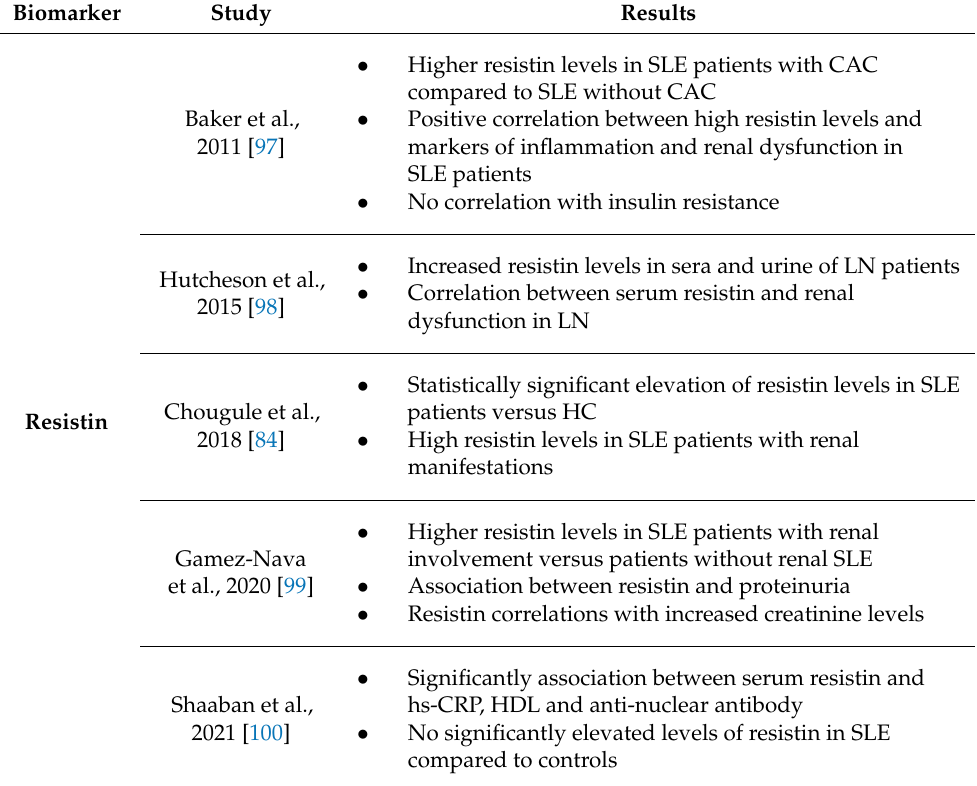
Table 5. Resistin in SLE